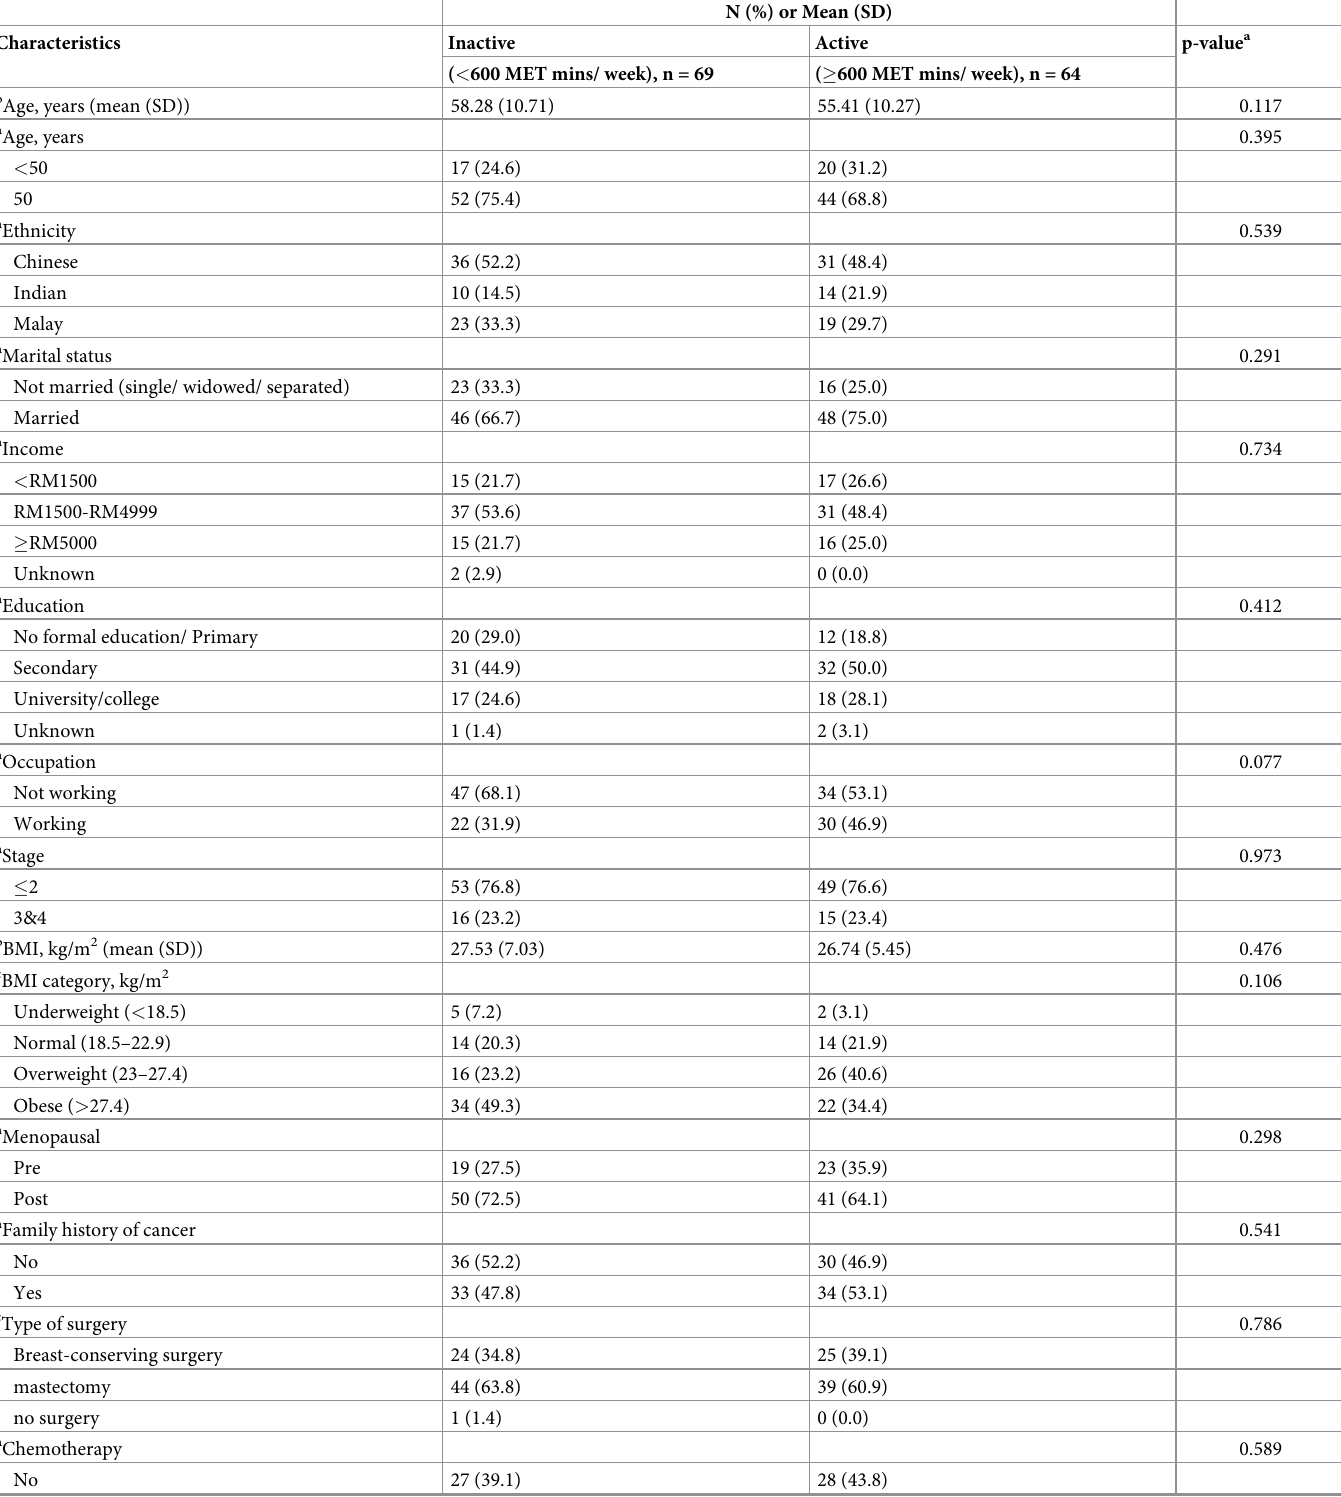
Table 2. Background characteristics of inactive vs. active patients at baseline, n =